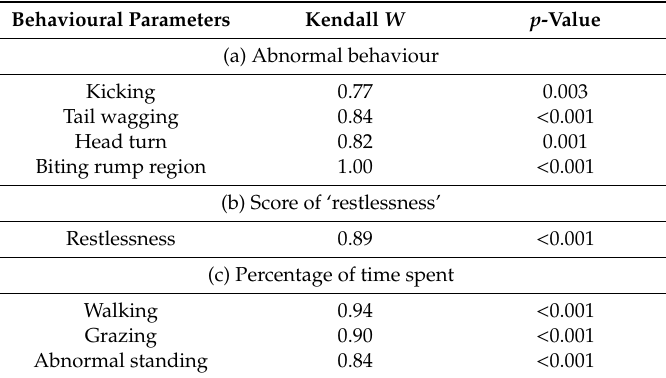
Table 2. The degree of agreement between observers on video-based assessment of sheep behaviour.